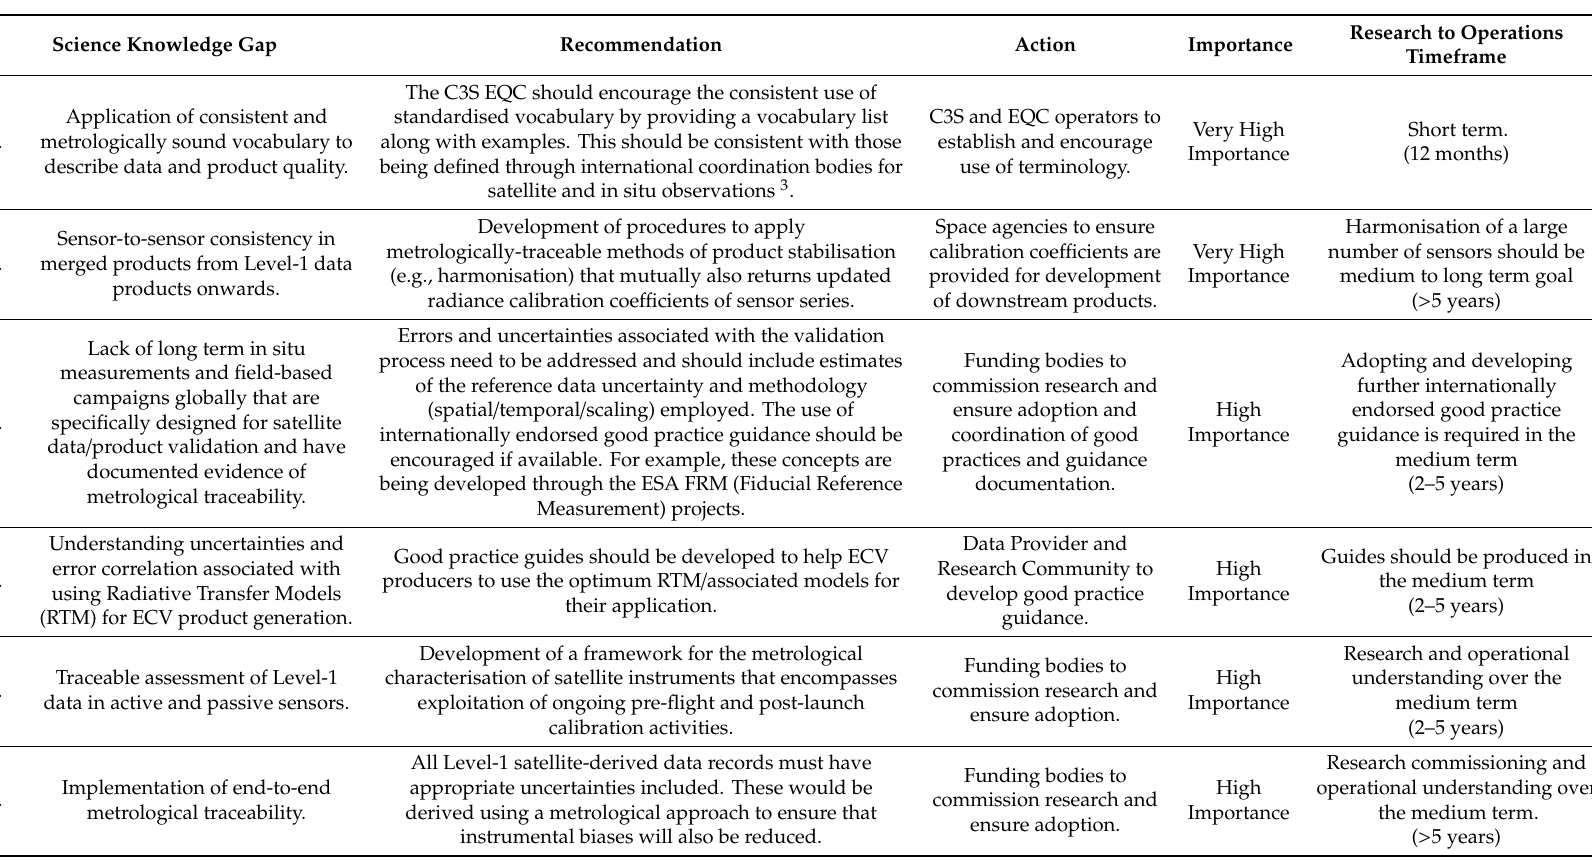
Table 3. Common cross-ECV domain science knowledge gaps that require action to ensure quality aspects of climate data sets from satellite and in situ observations can be ascertained and ensure users have access to the range of information necessary to confidently select relevant products for their specific applications. In all cases, international coordination or endorsement of methods is desirable 1 . Timeframes are indicative of how long it would take to conduct the research to reach operational